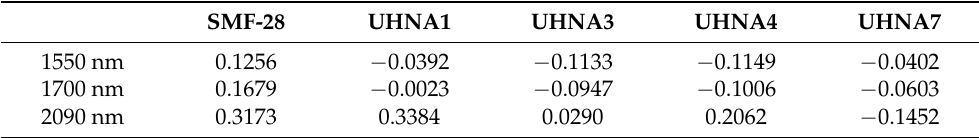
Table 2. β 3 coefficients (ps 3